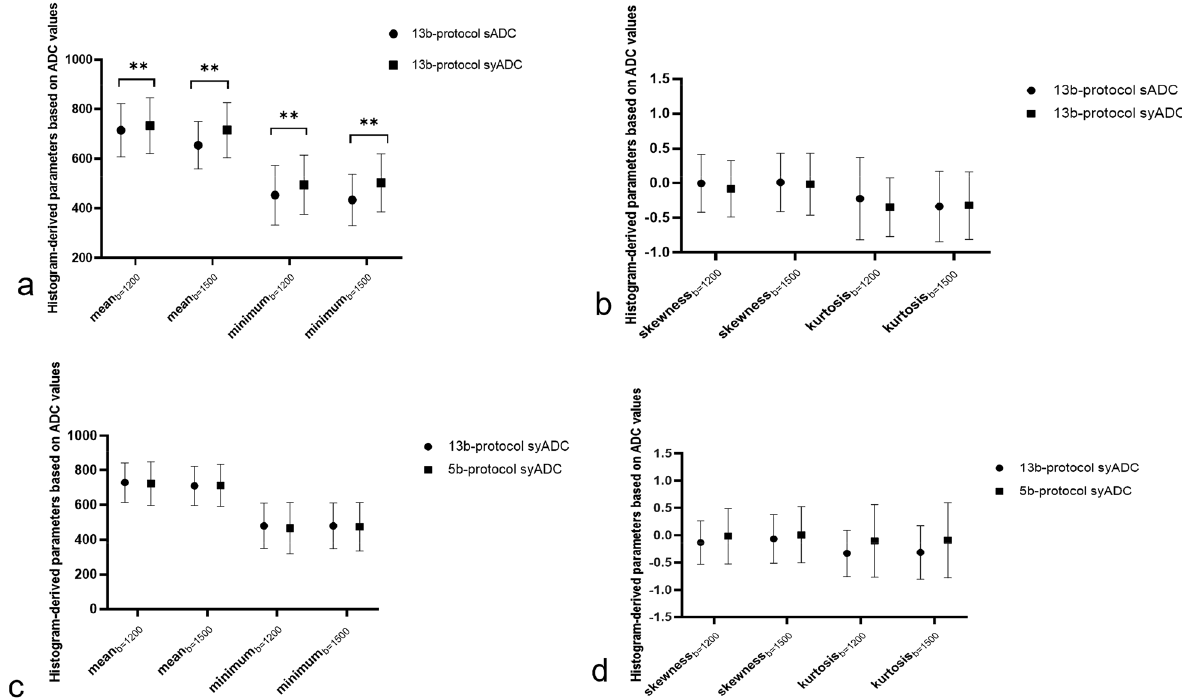
Fig. 3 Comparisons of histogram-derived parameters (mean minimum, skewness, and kurtosis): ( a, b ) based on 13b-protocol scanned and synthetic ADC values as well as those ( c, d ) based on 5b-protocol and 13b-protocol synthetic ADC values (** p <